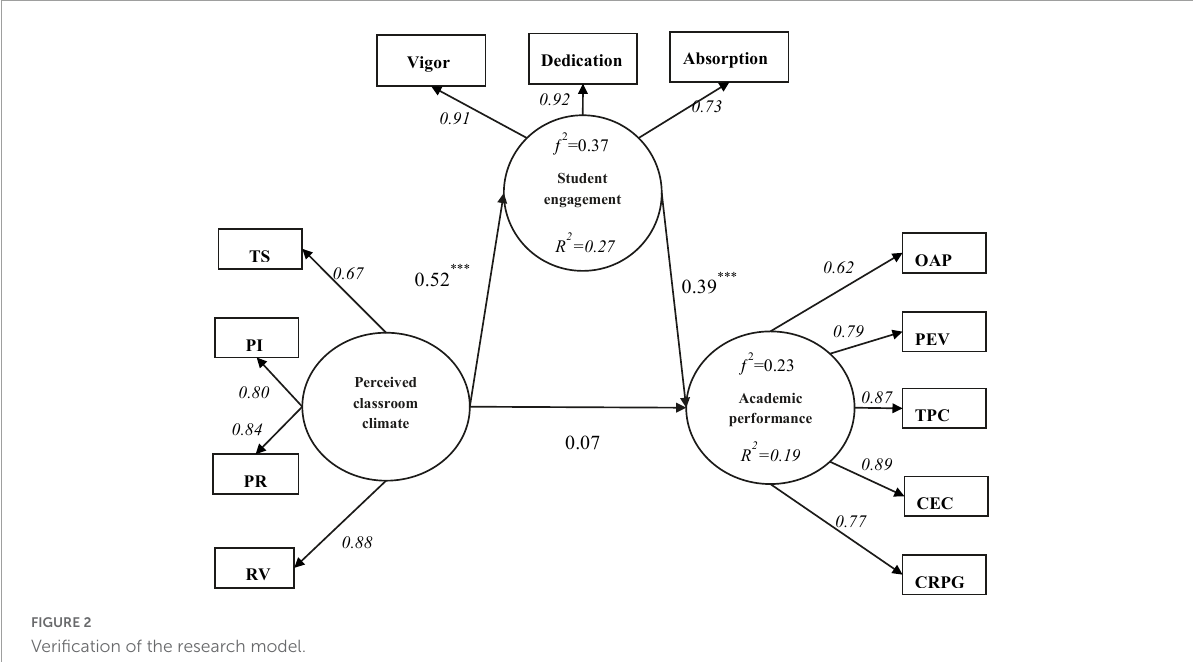
FIGURE2 Verification of the research